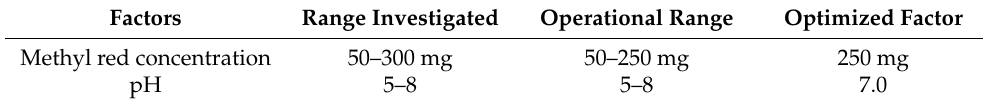
Table 1. The examined set of the decolorization variables selected for the optimization using co-